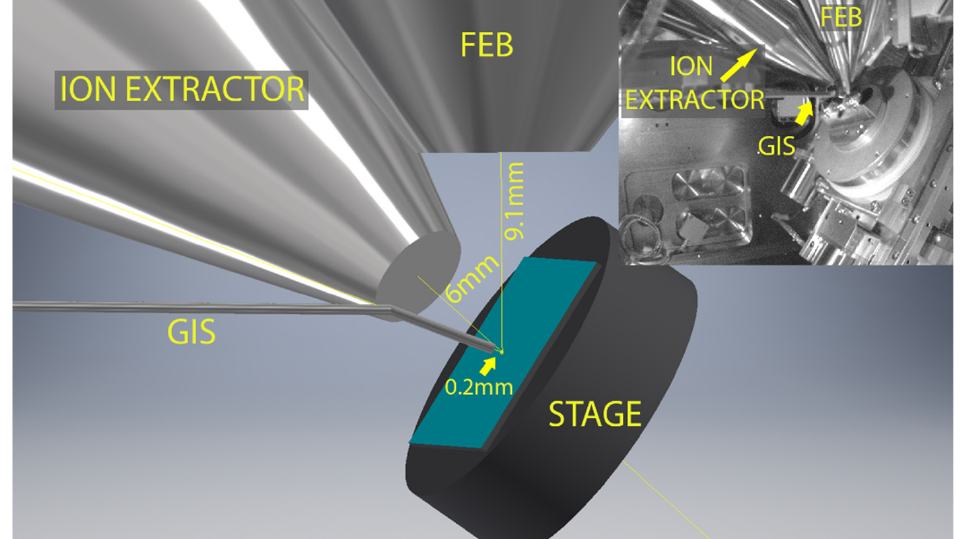
Figure 1. Schematic of the in situ FEBiMS experiment during FEBID with the gas injection system (GIS), the electrostatic lens ion extractor tube of the time-of-flight secondary ion mass spectrometer, the objective lens of the focused electron beam (FEB), and the sample stage with sample (s). The working distances are indicated. Inset: In-chamber view of measurement setup (infrared camera image). Note that there is no post-ionization involved in FEBiMS.